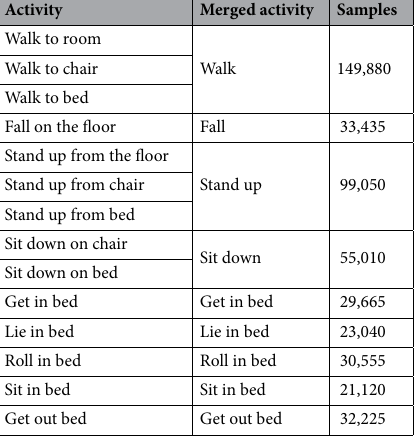
Table 1. Classes available in PARrad, including the transformations made by combining different